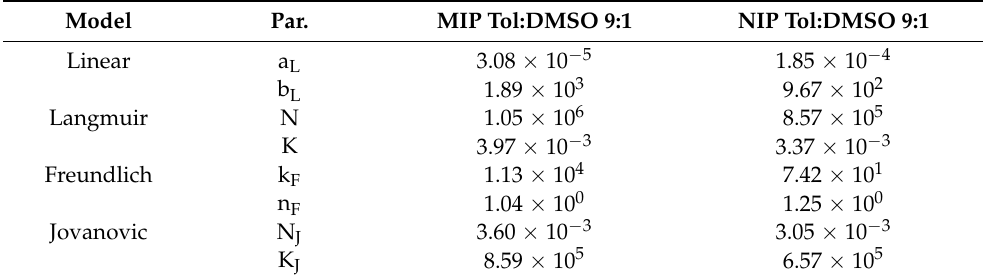
Table 4. The parameters of applied adsorption isotherms for MIP and NIP in 10% DMSO of coporogen.